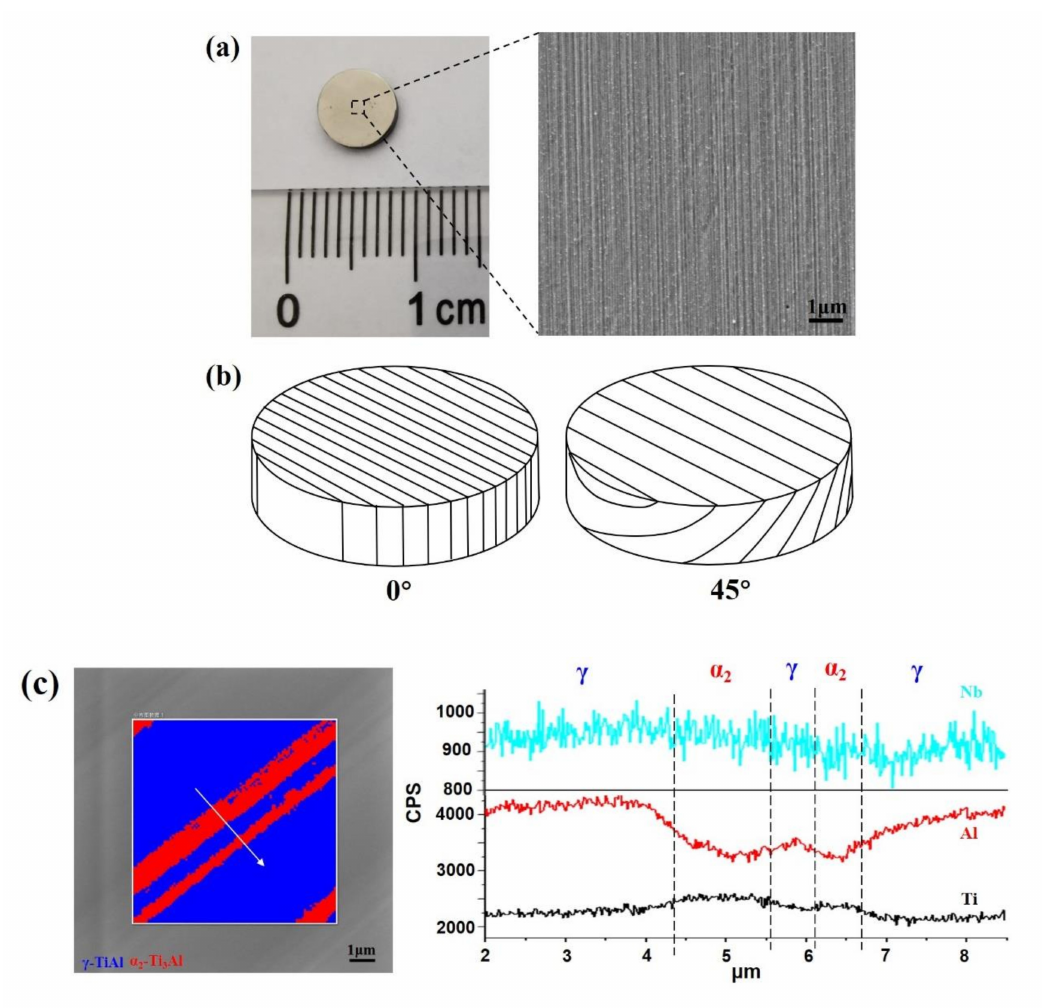
Figure 5. ( a ) small disk of TiAl lamellar sample; right side is the enlarged SEM image of lamellar structures, ( b ) schematic of the 0 ◦ and 45 ◦ oriented lamellae, ( c ) SEM-EDS of γ and α 2